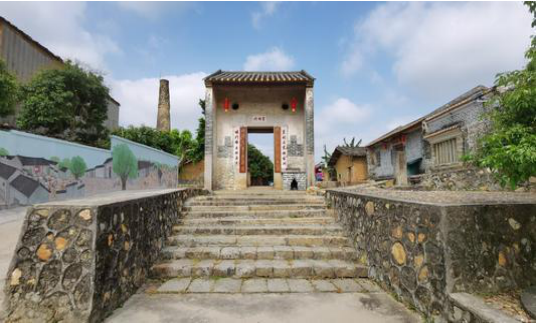
Figure 7. Spatial interface of Qiangang Village (source: the authors).